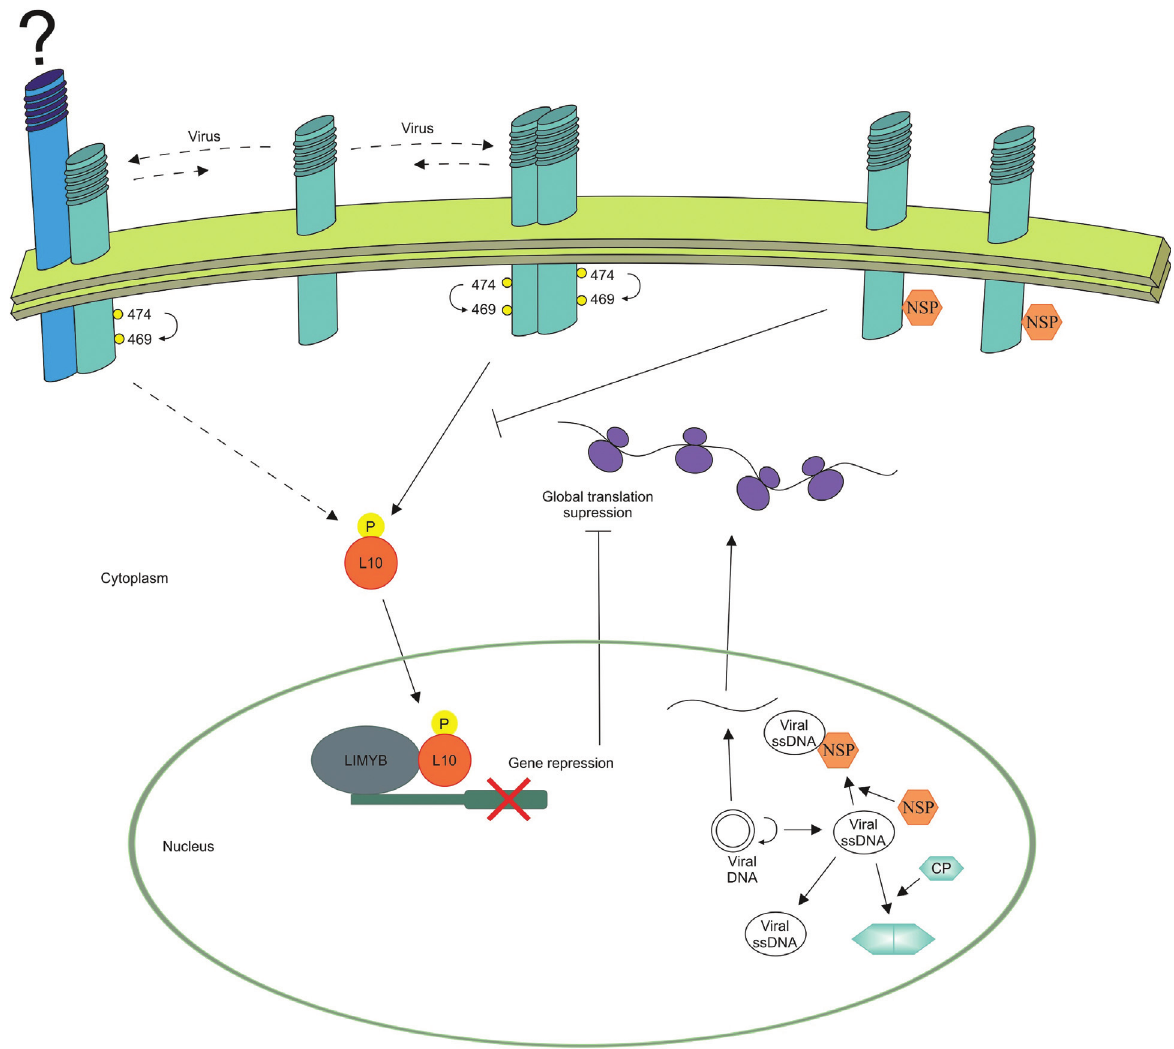
Figure 3 - Mechanistic overview of the antiviral defense pathway mediated by NIK1. Upon virus infection, NIK1 forms a homodimer and is activated throughtransphosphorylationofitskinasedomainattheThr-474residue.Alternatively,NIK1bindstoanunknownligand-bindingLRR-RLKinastimu- lus-dependent manner. The activation of NIK1 triggers the phosphorylation of RPL10 that, in turn, is transported to the nucleus. In the nuclear compart- ment, RPL10 interacts with LIMYB, which binds to the promoter of ribosomal protein (RP) genes to repress their transcription. As a consequence, a sup- pressionofhostglobalproteinsynthesisisobserved,whichalsoimpairstranslationofviralmRNA.Asadefensecountermeasure,NSPofbegomoviruses binds and inhibits the NIK1 kinase activity, which impairs the RPL10 phosphorylation. Thus, RPL10 is retained in the cytosol, enhancing begomovirus infection. As begomoviruses have single-stranded circular DNA genomes, they replicate in the nucleus of the infected cells by double-stranded DNA in- termediaries, which are also template for transcription of viral mRNAs. NSP binds to nascent viral DNA and facilitates the traffic of viral DNA from the nucleus to the cytoplasm by an unclear